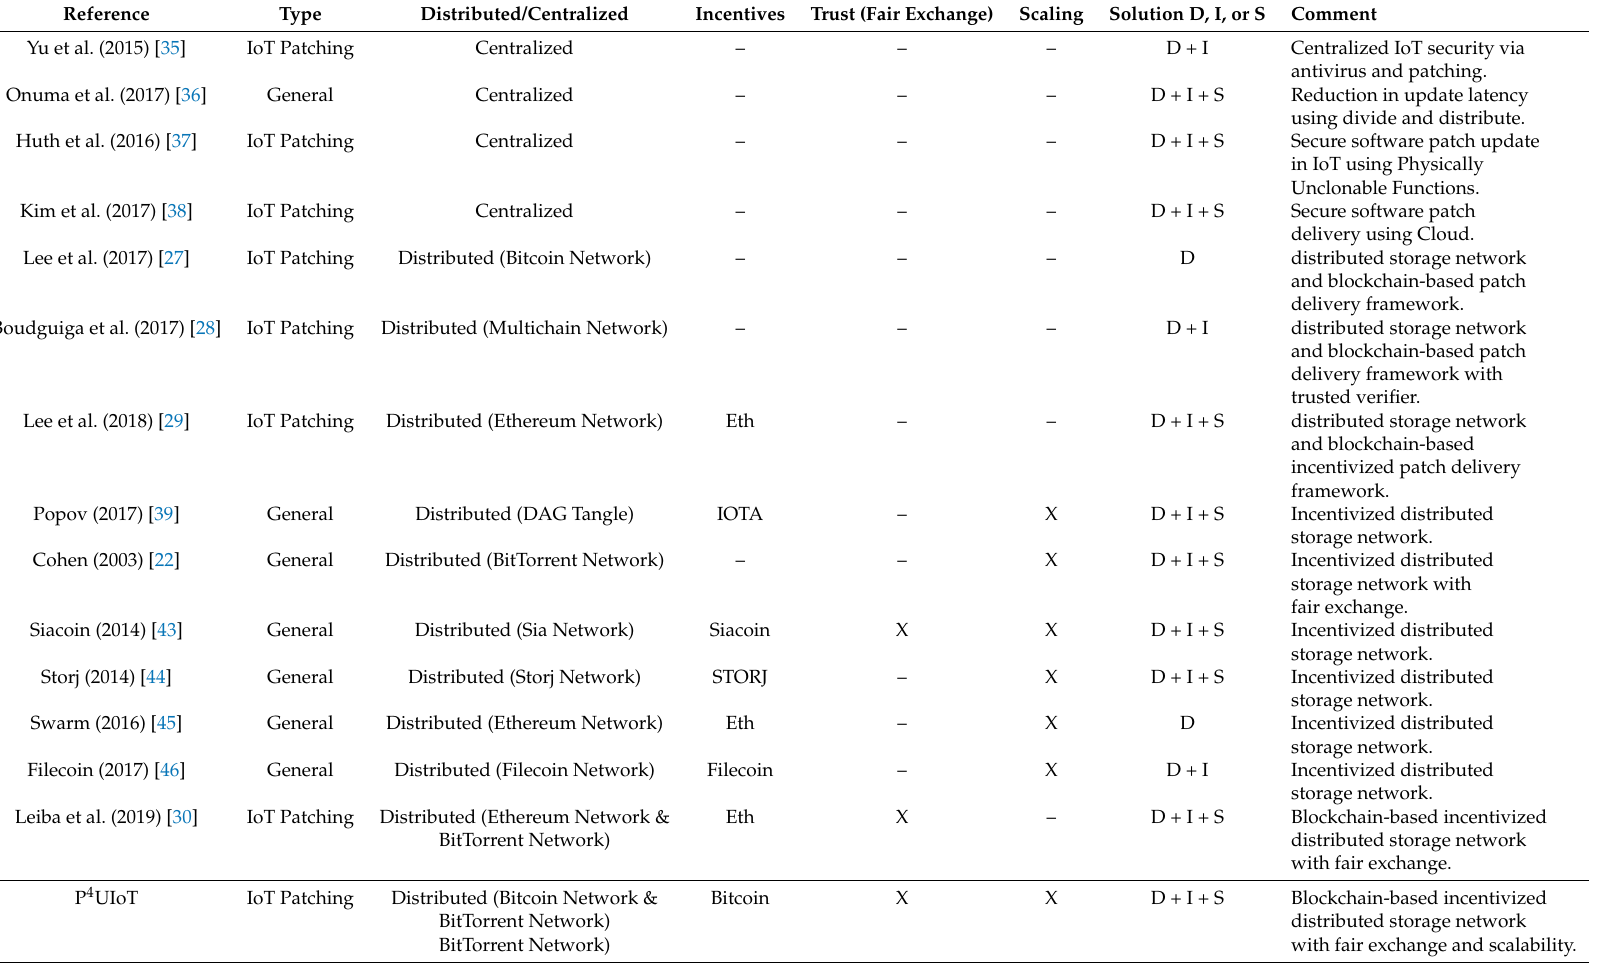
Table 1. Summary of related works (in the Solution column, D stands for design, I stands for implementation, and S stands for